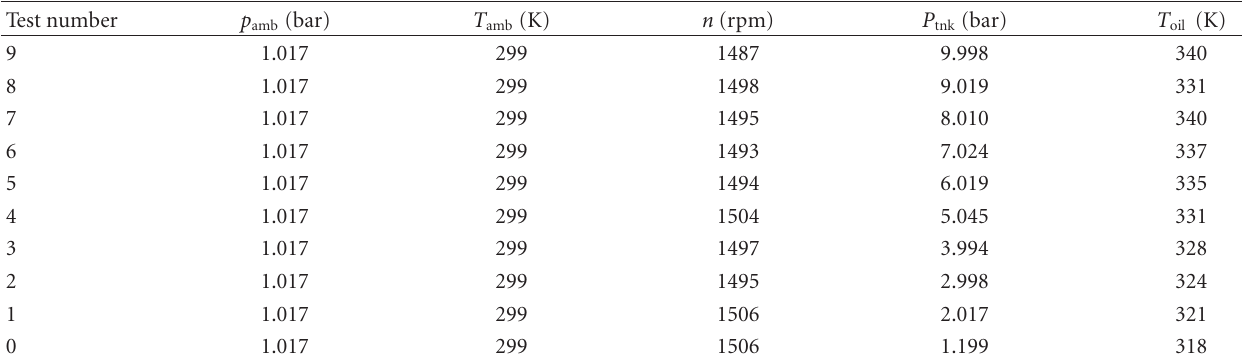
Table 1: Experimental